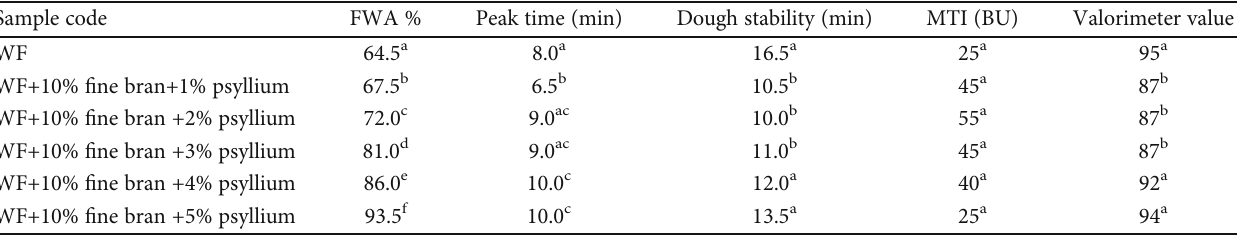
Table 3: Farinograph characteristics of dough made from fl our, fi ne bran, and psyllium blends.